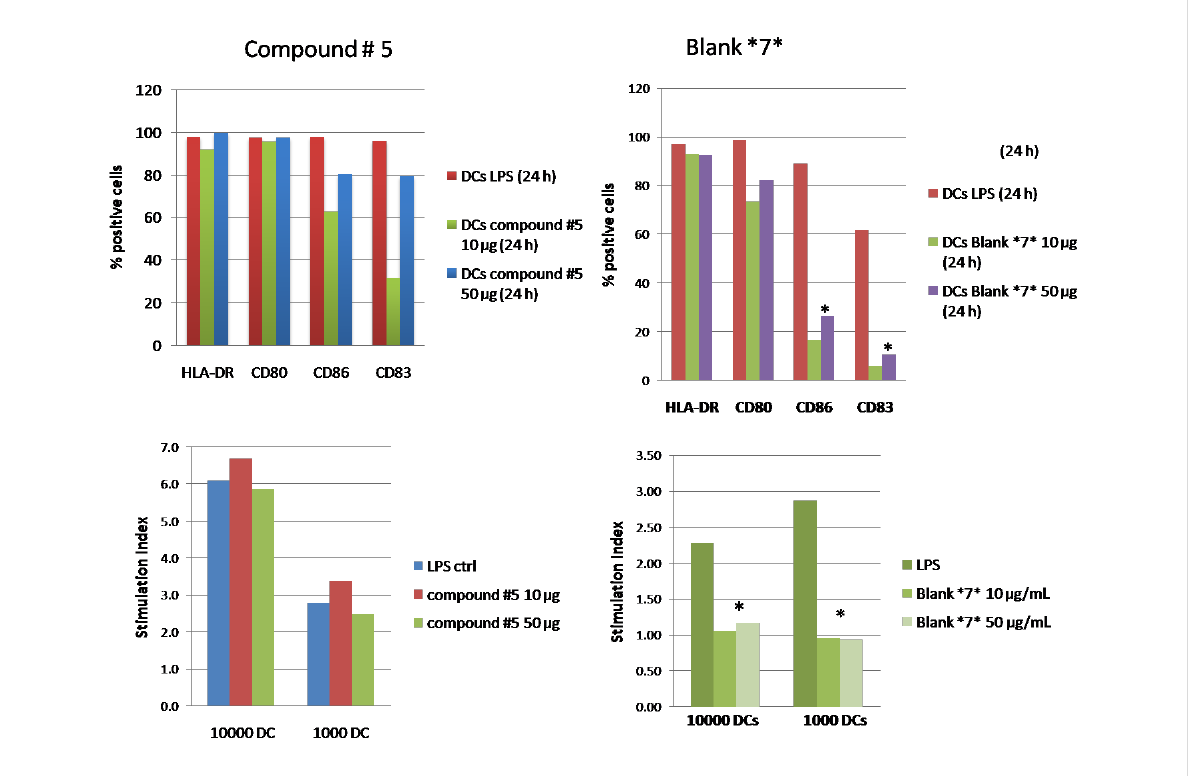
Figure 2: Upper panels: percentage of expression of dendritic cell markers (HLA-DR ECD, CD80 FITC, CD86 PE and CD83 PC5). Cell phenotypes, expressed as the percentage of positive cells for CD80, CD86 and HLA-DR, did not change when activation took place in the presence of compound 5 (left) at 10 or 50 µg/mL compared to LPS. CD83, an activation marker, was fully expressed at the higher dose of treatment. Compound 7 did not activate DCs when compared to LPS (right), differences between CD83 and CD86 expression are statistically significant at the two doses tested (* p < 0.05). One experiment is representative of three independent ones. Lower panels: mixed lymphocytes reaction (MLR). Compound 5 (left) at the dose of 10 or 50 µg/mL did not affect T lymphocyte proliferative response. As expected from the phenotype, scaffold (right) treated DCs at the dose of 10 or 50 µg/mL, significantly reduces the proliferative response (* p < 0.05). One experiment is representative of three independent ones. The analysis was performed by an unpaired t-test indicating that the mean is statistically significant at p <